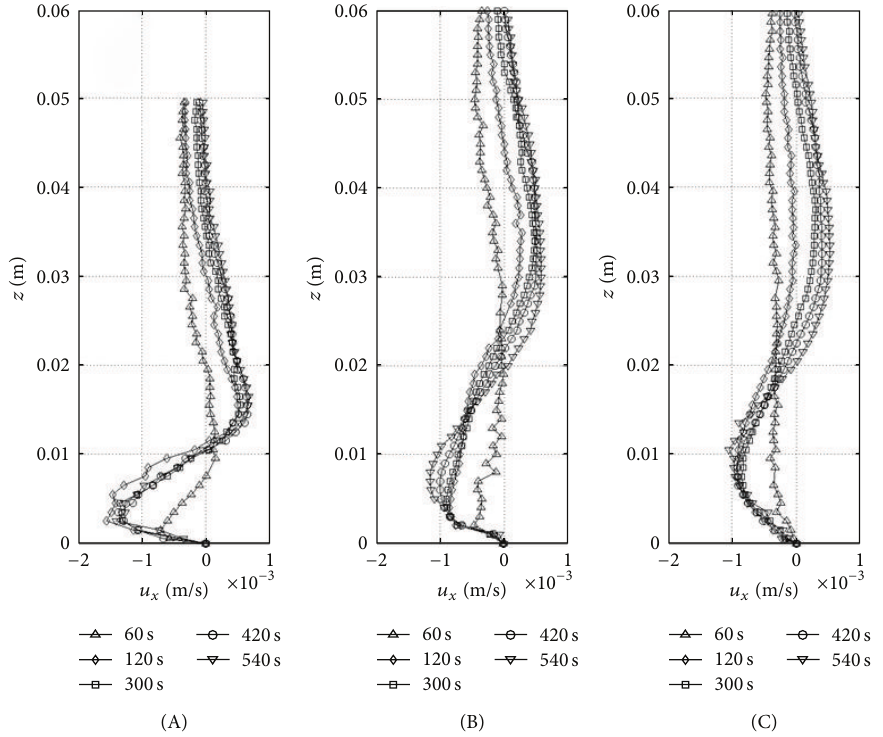
Figure 25: Velocity profiles A, B, and C at 5 time intervals from the beginning of experiment